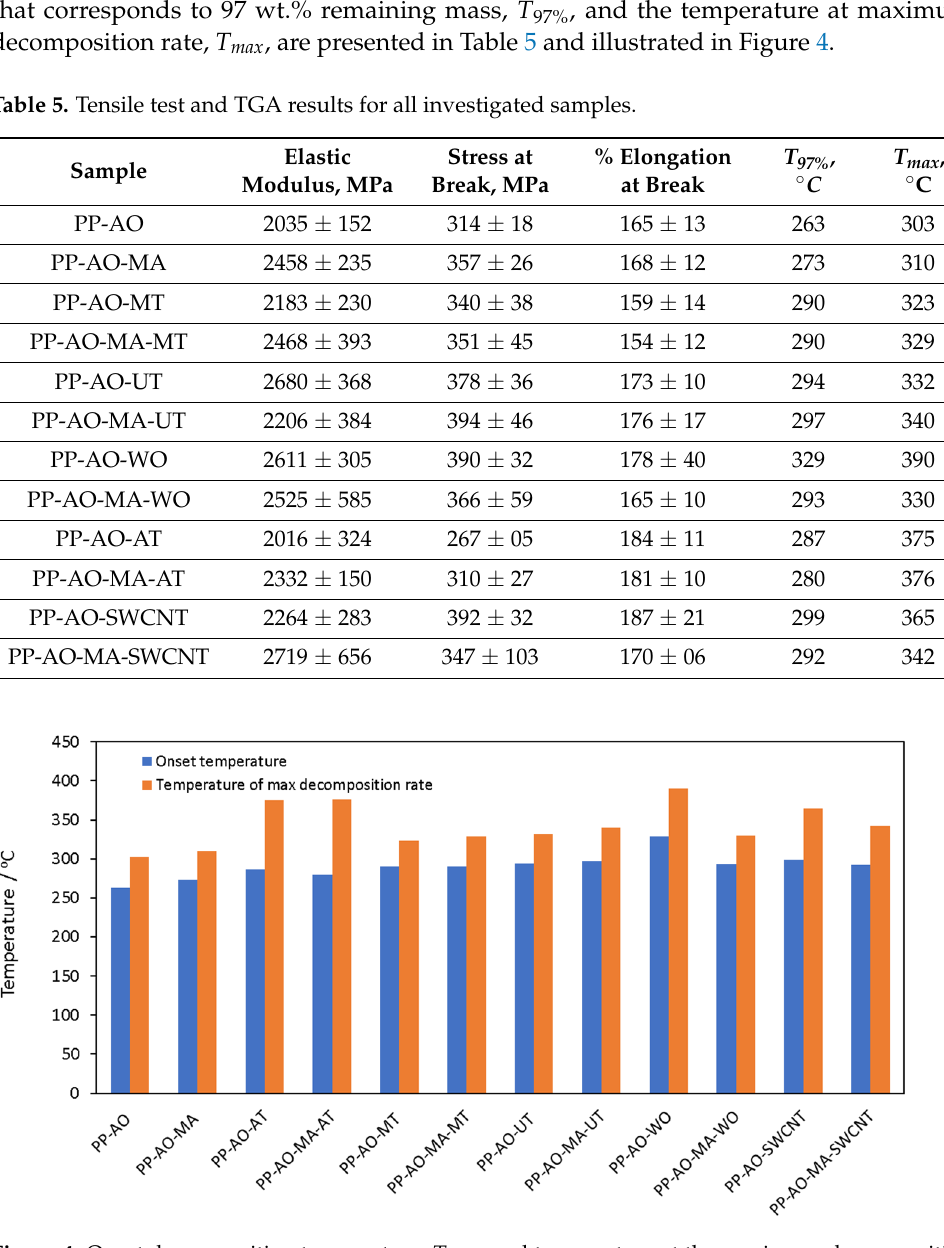
Figure 4. Onset decomposition temperature, T 97% , and temperature at the maximum decomposition rate, T max , for all investigated drawn fibers. Table 5. Tensile test and TGA results for all investigated samples.